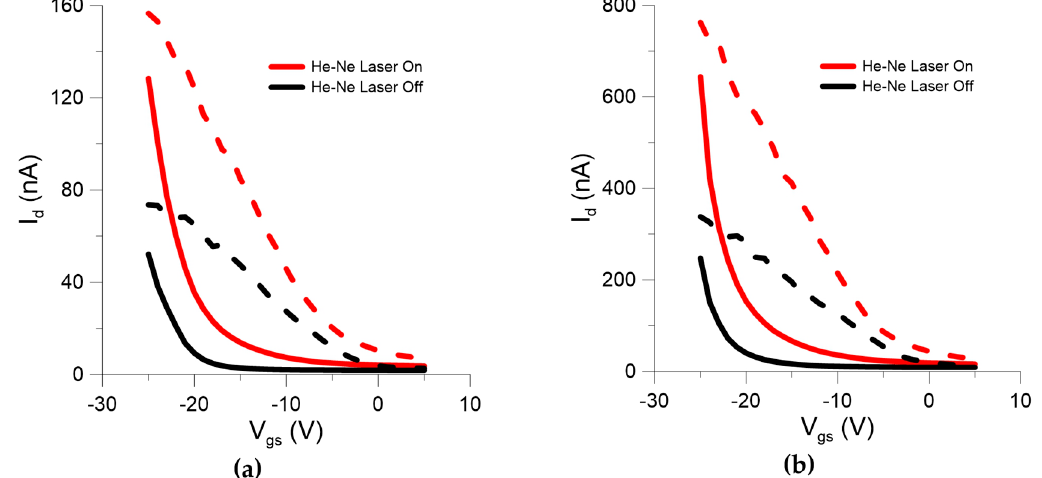
Figure 4. The Id-Vgs curves of the high density Si nanonet FETs when irradiation with He-Ne Laser was set on and off under gate voltage up (solid lines) and down (dashed lines) sweeps and a drain voltage of ( a ) V ds = 1 V and ( b ) V ds = 5 V.